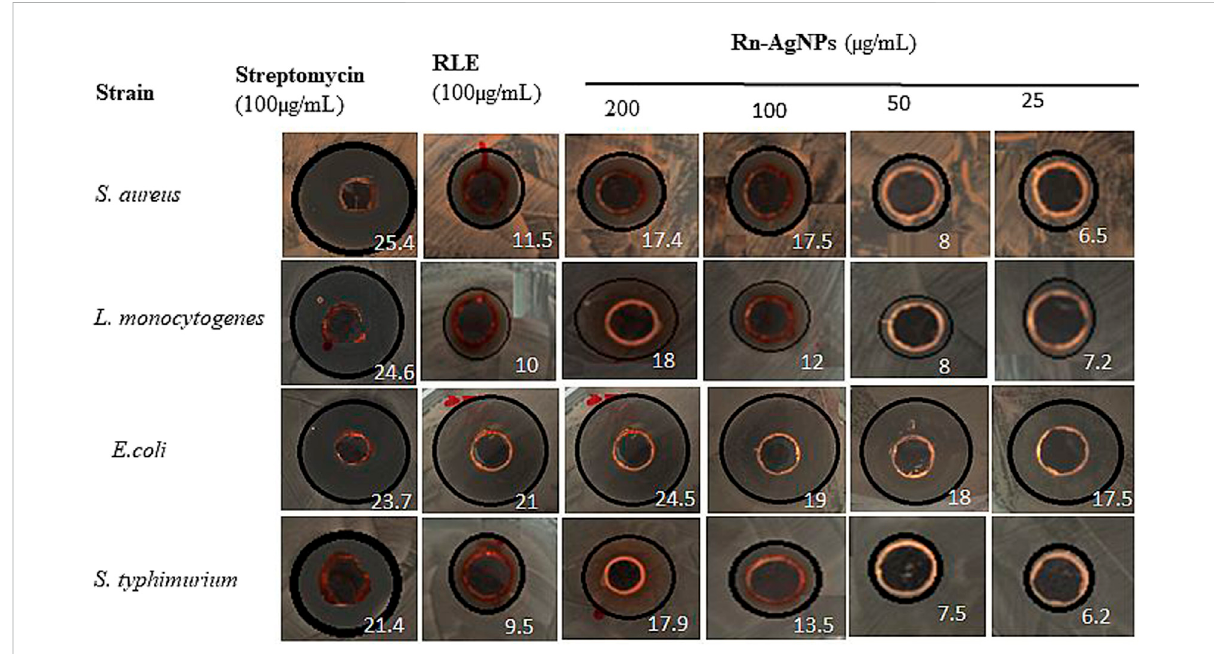
FIGURE 7 Zone of inhibition (mm) observed when gram-positive and gram-negative bacterial strains are treated with RLE and Rn-AgNPs in different concentrations. Values in white color represent zone of inhibition.